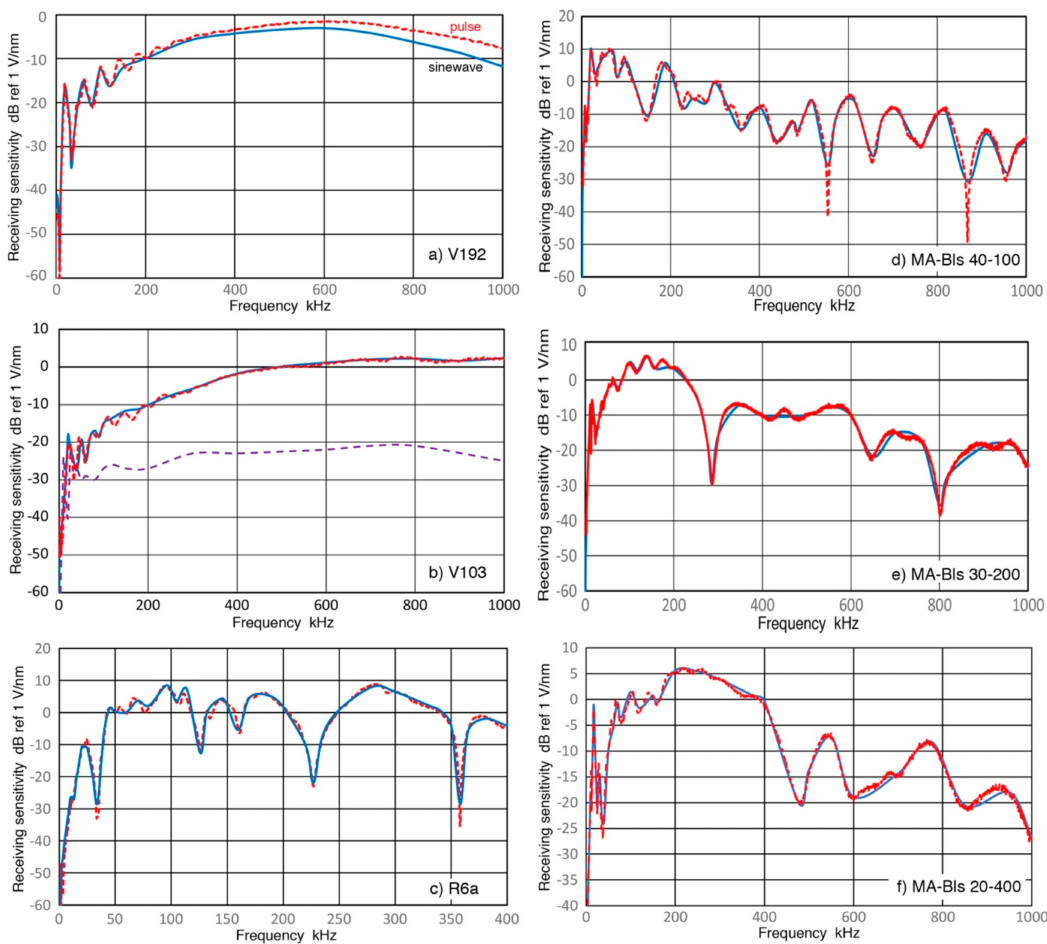
Figure A2. ( a ) Two sensitivity curves for V192 (Z in = 1 M Ω ) from Figure A1a are plotted in linear frequency scale in kHz. Receiving sensitivity spectra for sinewave (blue curve) and pulse (red dash curve) methods in dB scale as in Figure A1a; ( b ) Same for V103 (1.0); ( c ) Same for R6a (0.06); ( d ) Same for MA-Bls 40–100; ( e ) Same for MA-Bls 30–200; ( f ) Same for MA-Bls